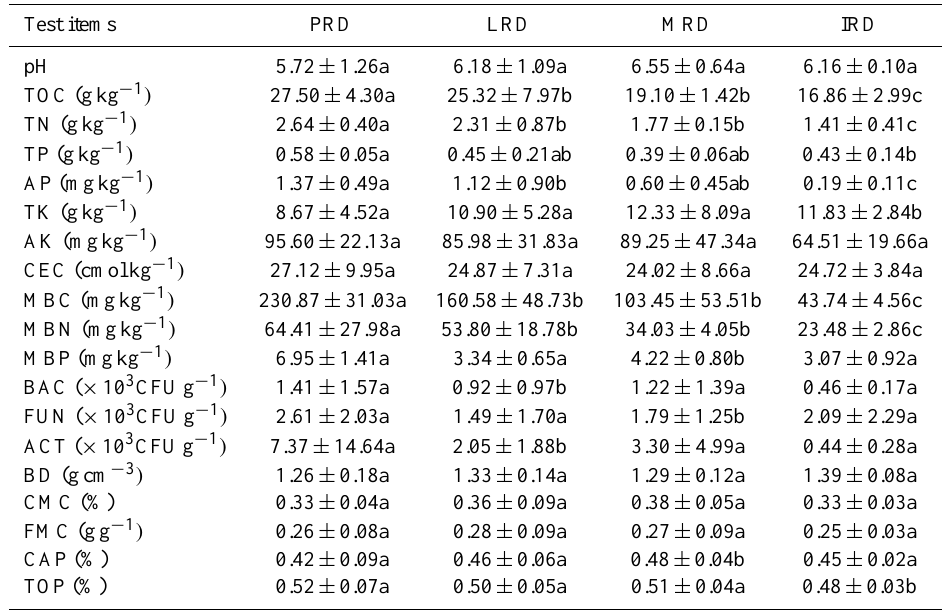
Table 2. Effects of succession of rocky desertification on soil fertility indicators. Test items